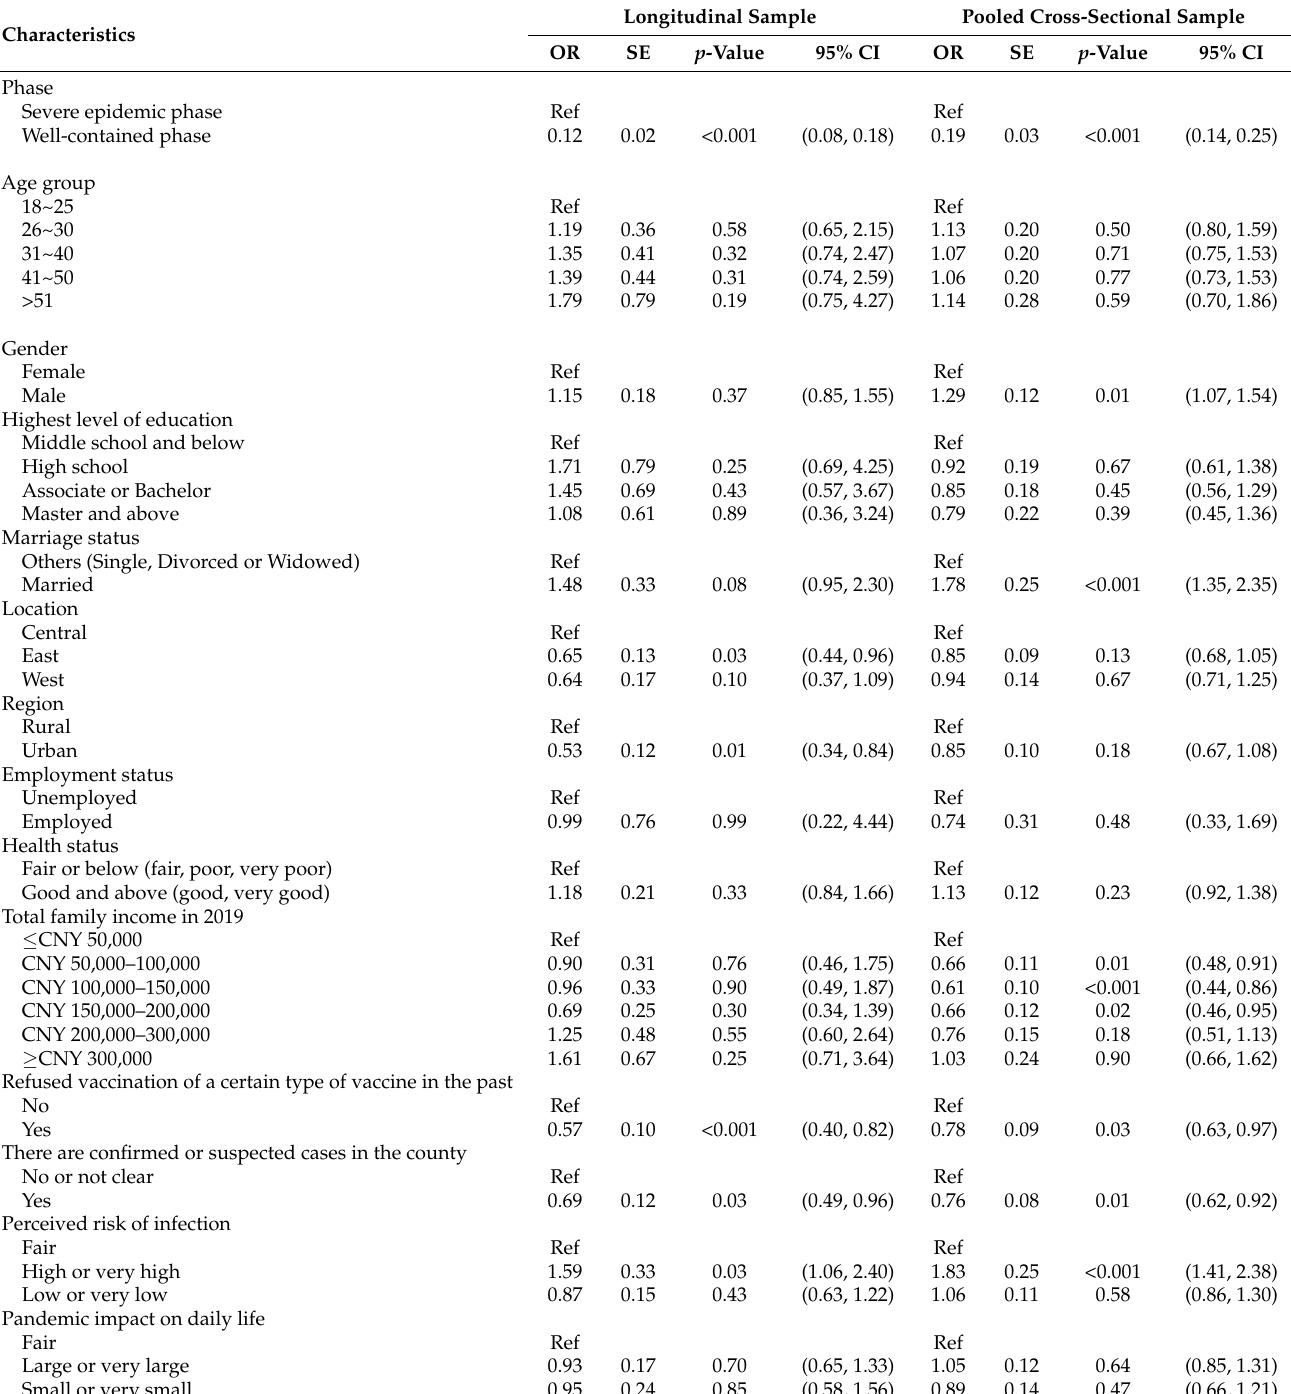
Table 2. Influencing factors of vaccination acceptance (immediate or delayed acceptance) between the vaccine demand group and vaccine delay